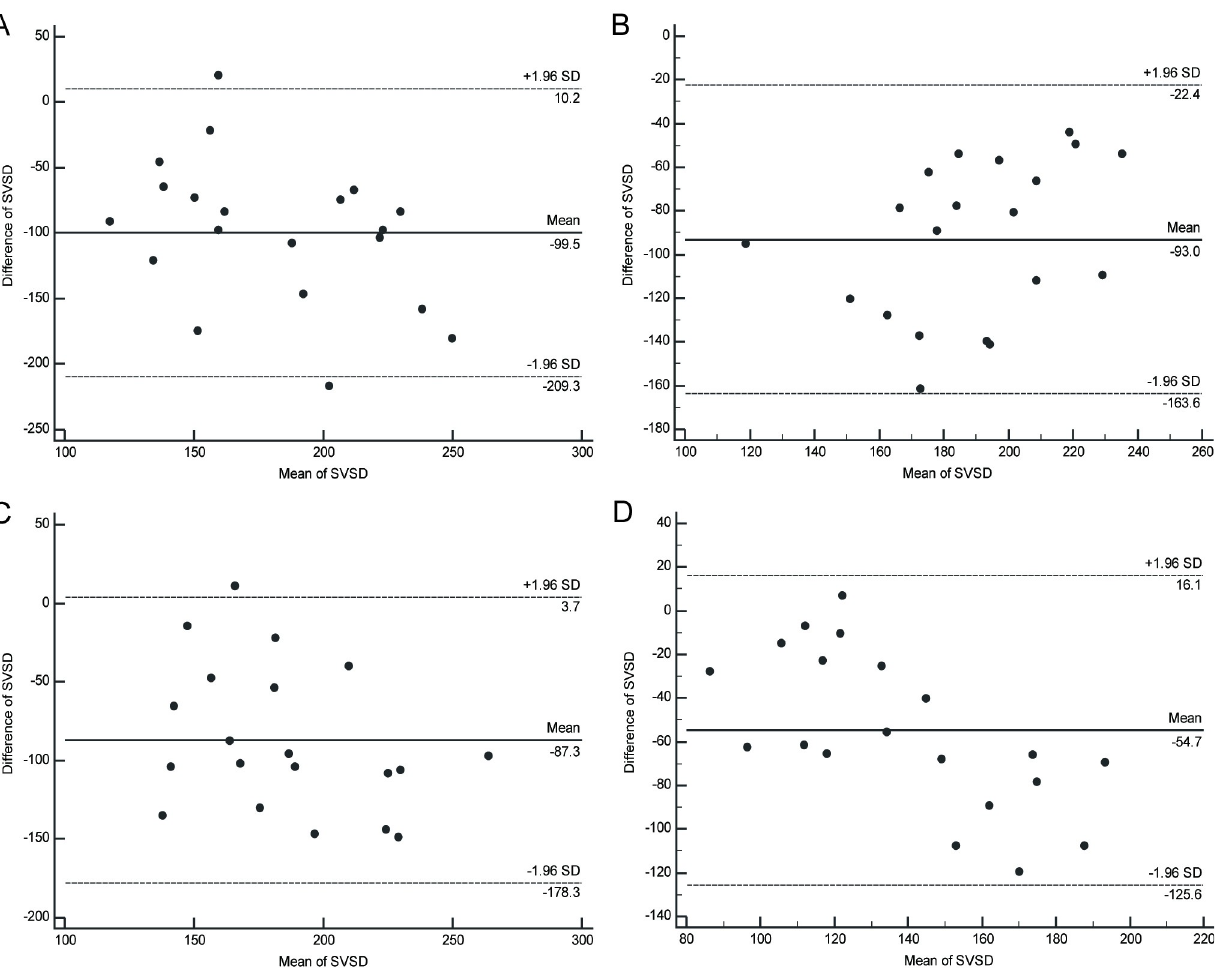
Fig 2. Zeiss and Heidelberg comparison using the SVSD parameter in each diabetic retinopathy severity group. Bland-Altman plots. Inconsistency between Zeiss and Heidelberg in all four diabetic retinopathy severity groups: (A) Group 1, (B) Group 2, (C) Group 3, (D) Group 4. The solid line indicates the mean of the differences; the upper and lower dotted lines indicate the upper and lower limits of agreement (LA). Group 1: nondiabetic controls; Group 2: diabetes without DR; Group 3: mild NPDR; Group 4: severe NPDR and PDR.